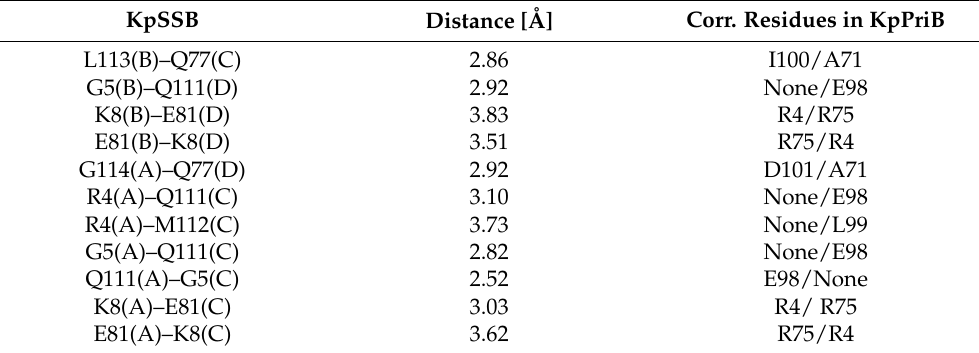
Table 2. The formation of hydrogen bonds and salt bridges at the dimer–dimer interface of KpSSB and the corresponding residues in KpPriB.